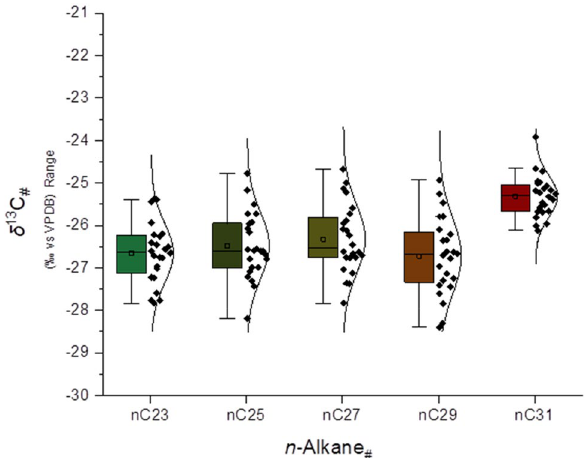
Figure 4. Compiled leaf-wax n-alkane signatures of 24 sediments samples excavated from at AGS. Stable carbon isotopic values of C 23–C31 n-alkanes (δ 13 C # ) are shown as median values with their median absolute deviation (± MAD) and ANOVA test distributions. Boxplots depict distributional differences between individual homologue δ 13 C #